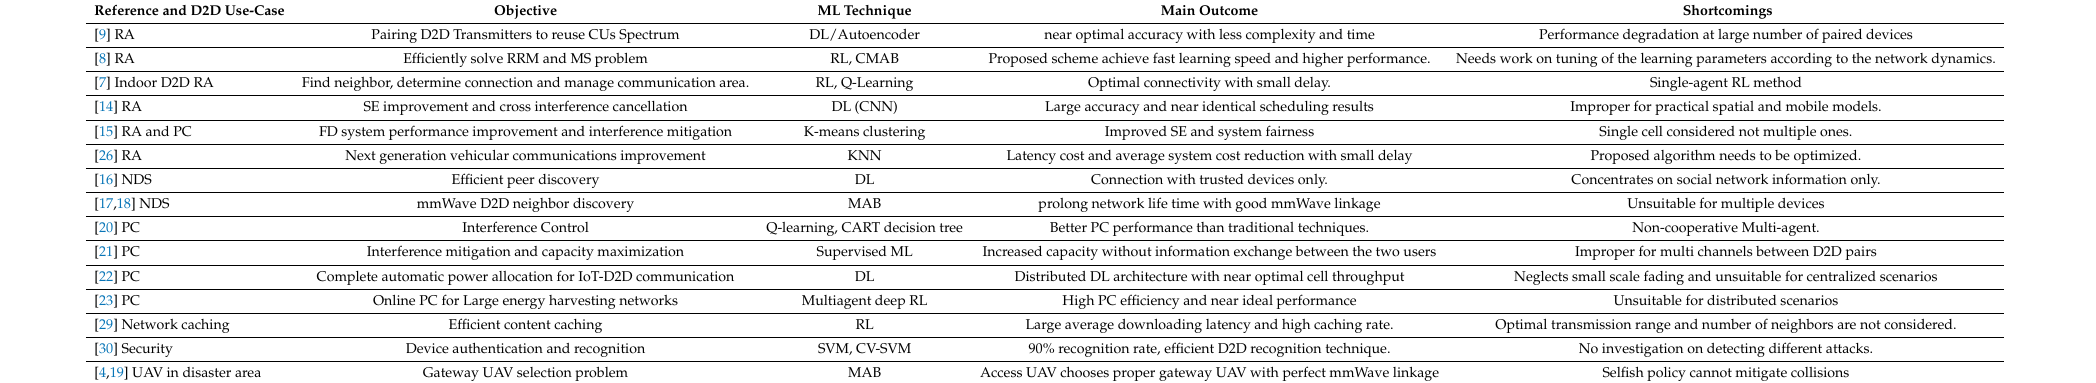
Table 2. ML-based D2D